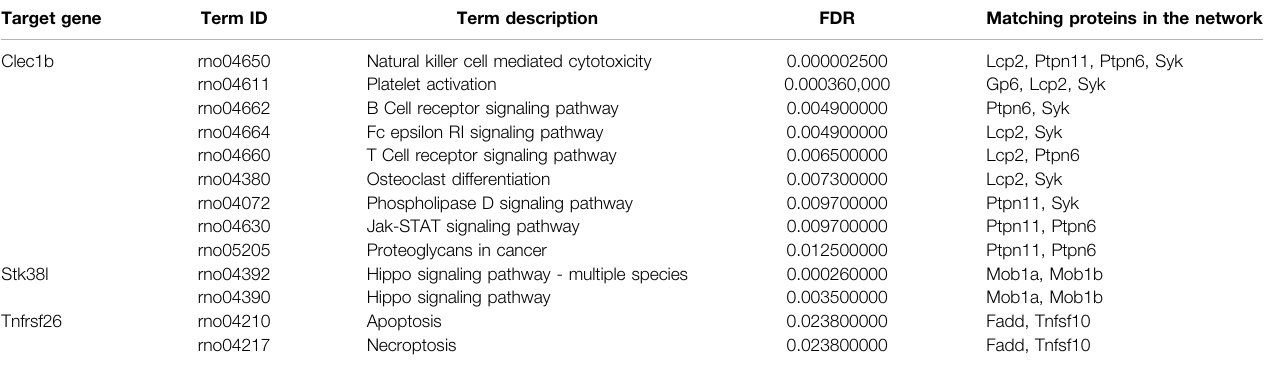
TABLE 6 | Pathways of the matching proteins in the PPI network. Target